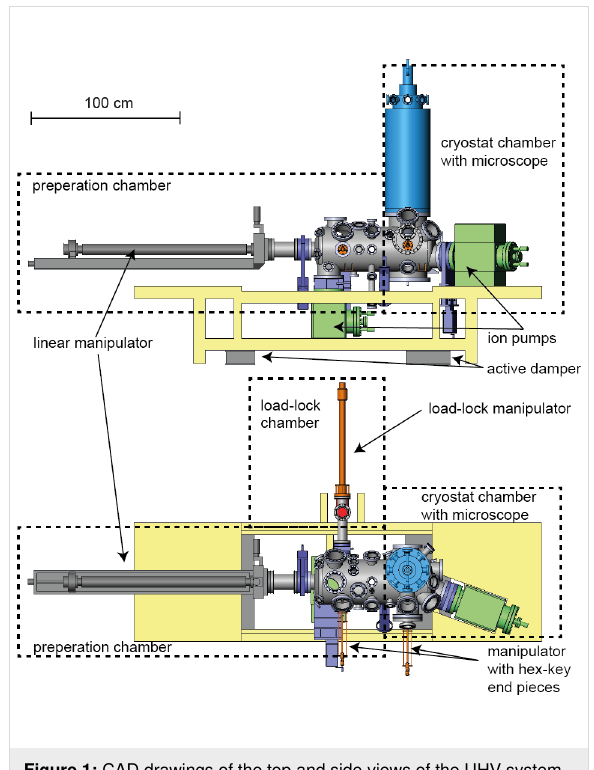
Figure 1: CAD drawings of the top and side views of the UHV system consisting of a cryostat chamber, a preparation chamber, and a load- lock